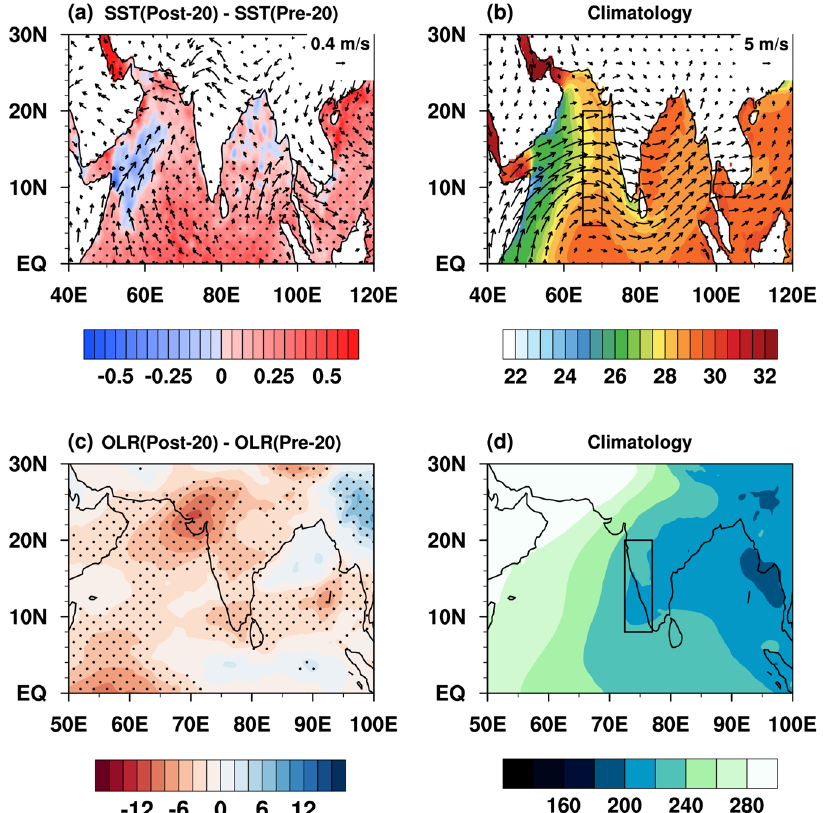
Fig. 3 Changes in SST and OLR. a Anomaly (post-20 minus pre-20) JJAS composite SST(unit:°C) with stippling indicates statistically signi fi cant areas at a 99% con fi dence level, overlaid with 850 hPa vector winds(unit:ms − 1 ) signi fi cant at a 99% con fi dence level. b SST Climatology. c , d As above but for OLR(unit:Wm − 2 ). The boxes in a and d represents the eastern-Arabian sea (5 – 20 °N, 65 – 70 °E) and west coast of India (8 – 20 °N, 73 – 77 °E),